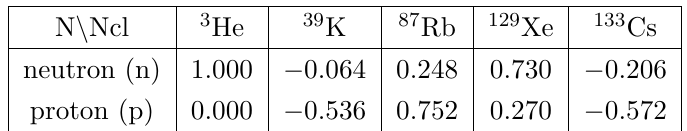
Table 2 . Numerical values for g N